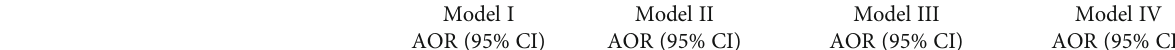
Table 2: Multilevel logistic regression analysis of individual- and community-level factors associated with childhood diarrhea in Ethiopia,